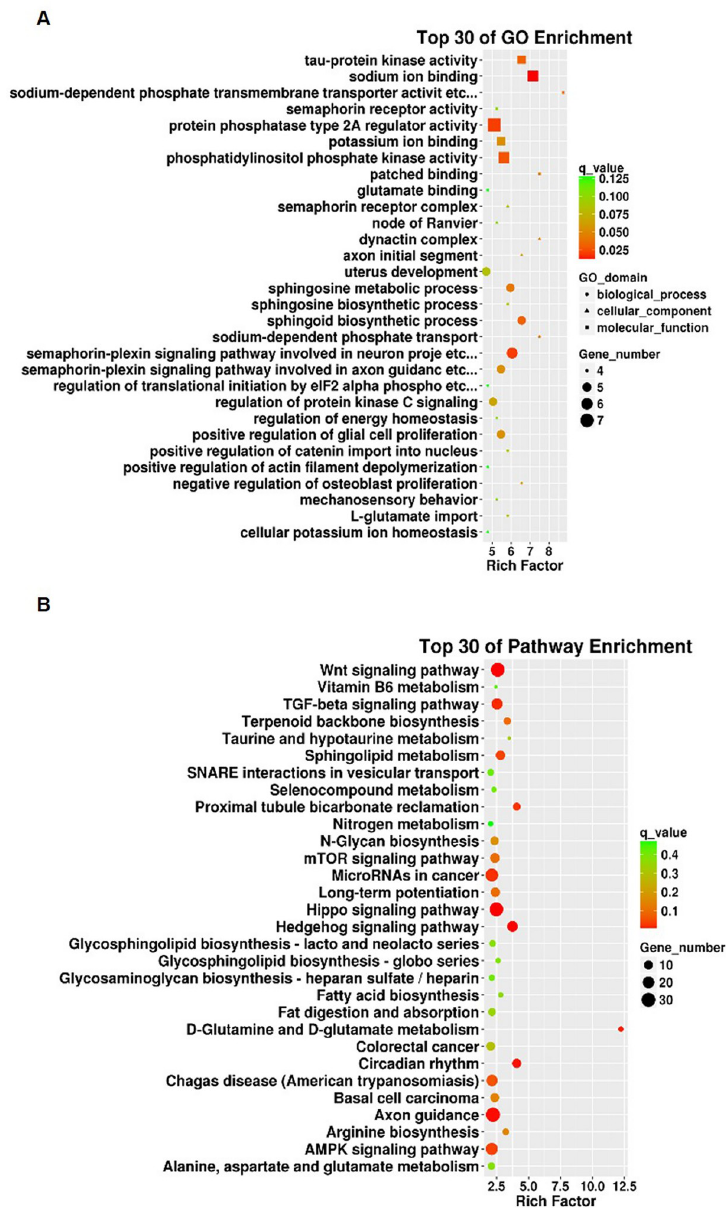
Fig 3. Functional enrichment analysis of the mature DE miRNAs and their putative targets. (A) The enriched top 30 GO terms ( P < 0.05). (B) The enriched top 30 pathways of KEGG analysis ( P < 0.05).